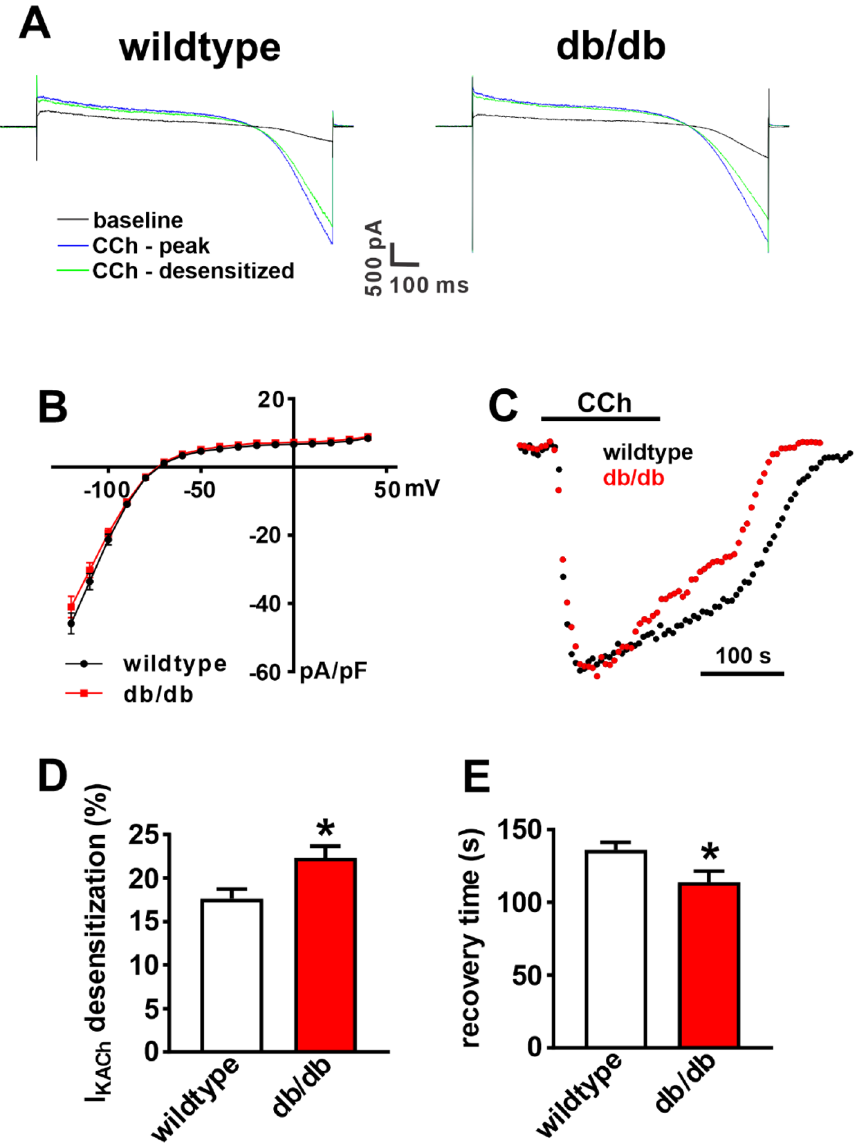
Figure 4. I KACh properties in isolated SAN myocytes from db/db mice. ( A ) Representative I K recordings during a voltage ramp from + 50 mV to − 120 mV (holding potential = − 80 mV) at baseline, at the peak of the CCh (10 µM) response and 2 min after the peak CCh response in wildtype and db/db SAN myocytes. ( B ) Peak I KACh I–V relationship in wildtype ( n = 28) and db/db ( n = 25) SAN myocytes. P = 0.998 for wildtype vs. db/db by two-way repeated measures ANOVA with Holm–Sidak posthoc test. ( C ) Time course of CCh stimulated I KACh , measured at − 100 mV, in wildtype and db/db SAN myocytes. ( D ) Summary of I KACh desensitization in